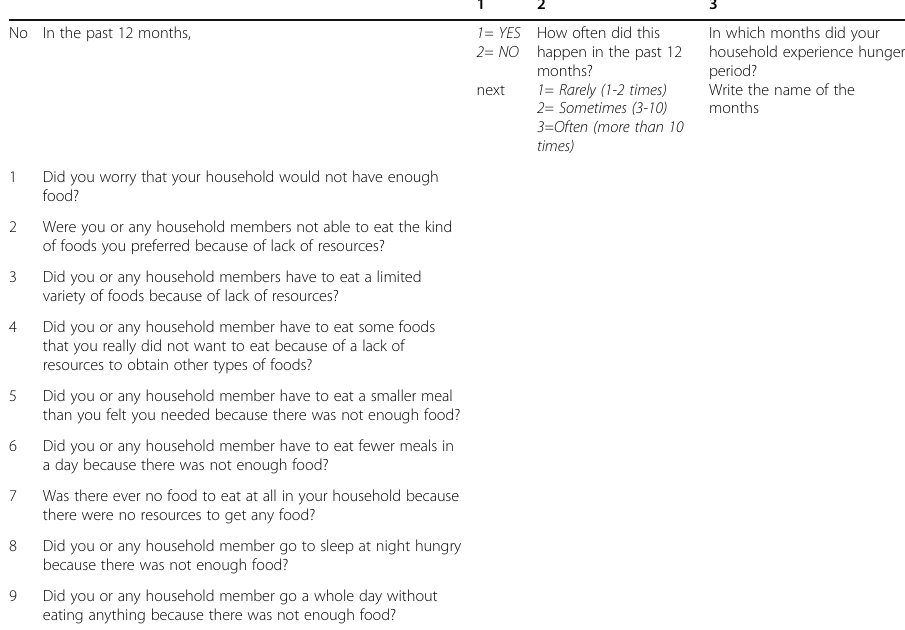
Table 6 Questions in the food security module of the survey. We would like to ask you the food security situation of your household during the past 12 months 1 2 3 No In the past 12 months,